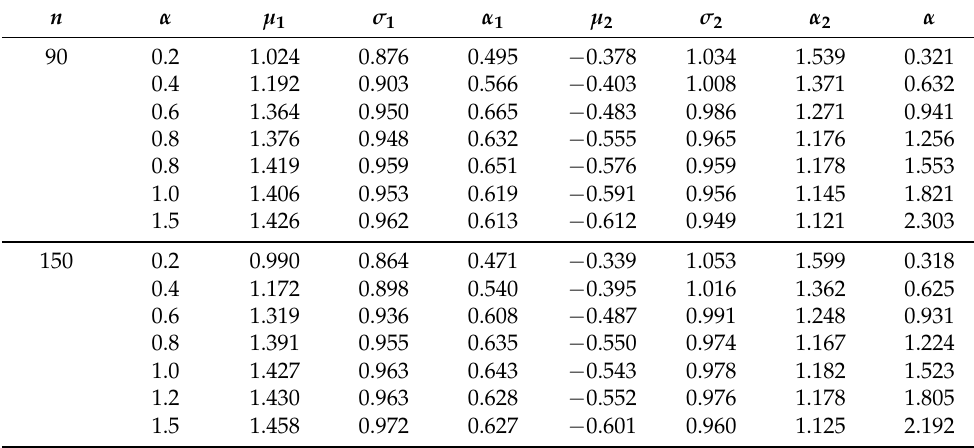
Table 1. Parameter estimates; empirical